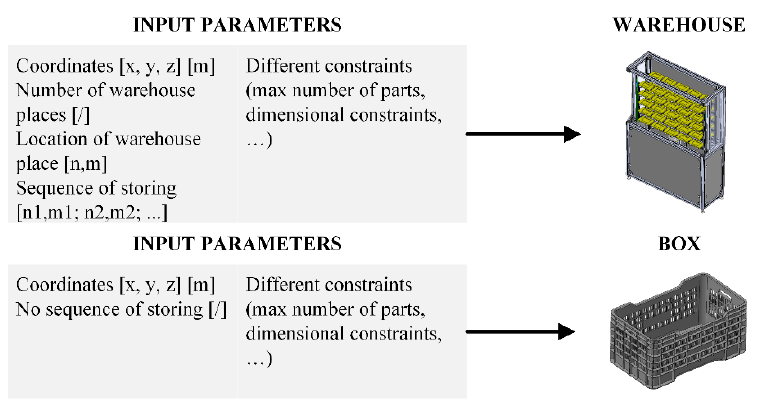
Figure 7. Examples of “Storage” building blocks.